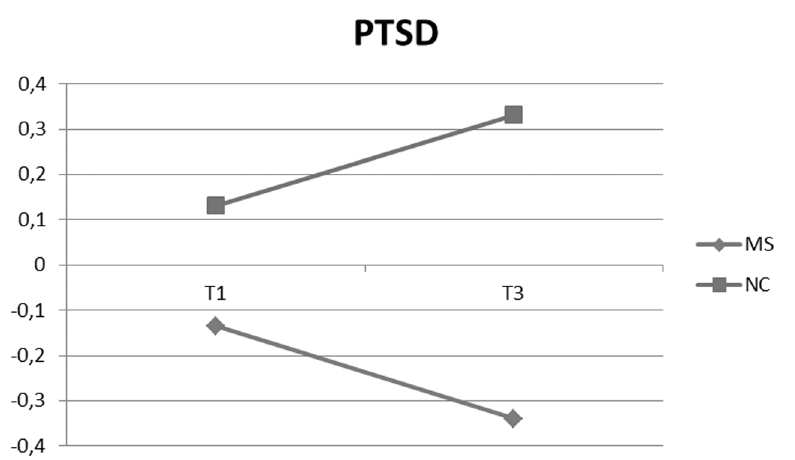
Figure 2. Writing conditions and mean of PTSD total scores (z-Scores) at T1 and T3.